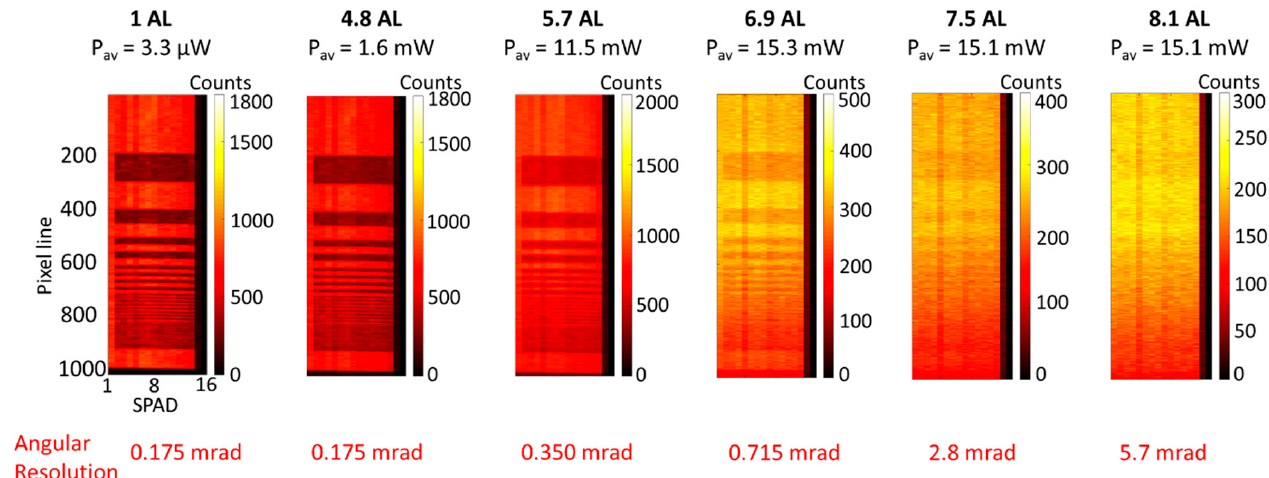
Figure 8. Intensity profiles of the variable lines resolution target (as shown in Figure 3c) in unfiltered tap water and several concentrations of scattering agent. The acquisition time per line was set to 10 ms, and the average optical power was adjusted from 3.3 to 15.3 mW, depending on the level of scattering in water.